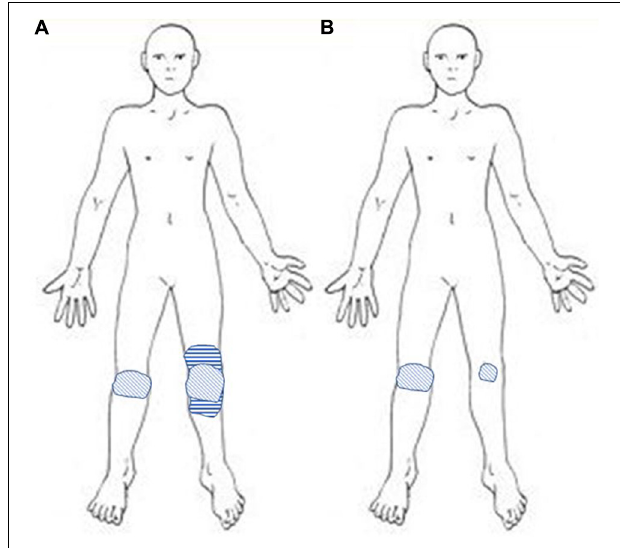
FIGURE 1 | (A) Before rTMS: drawing of the extent of mechanical pain (hatched area), surrounded by a region of exacerbated permanent pain with mechanical allodynia evoking central sensitization on the left side only (horizontal stripes). (B) After 10 rTMS sessions: the area of mechanical pain is reduced and the zone likely related to central sensitization disappeared on the left side, whereas pain remained unchanged on the right